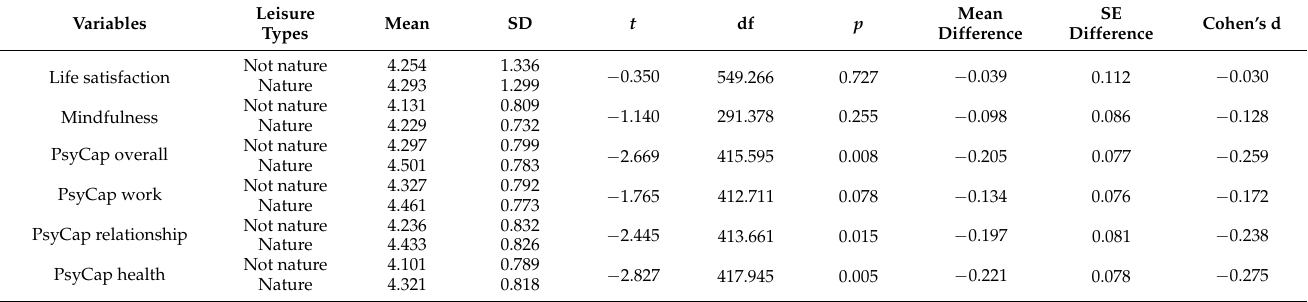
Table 10. Comparison (Welch’s t -test) of life satisfaction, mindfulness, and psychological capital in groups of respondents who prefer and do not prefer spending leisure time in nature.